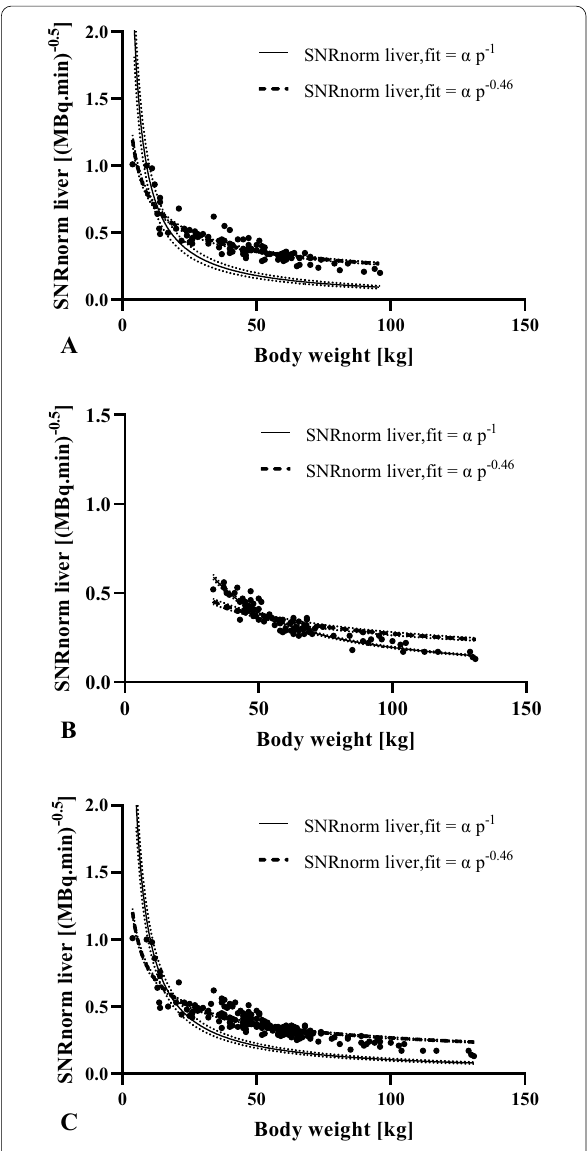
Fig. 3 Comparison between SNRnorm liver fits that corresponds with the proposed nonlinear dosage regimen (parameter d fixed to 0.46) and a quadratic dosage regimen (parameter d fixed to 1) for children ( a ), adults ( b ) and both groups ( c ). The dashed lines represent the 95% confidence intervals of the fits